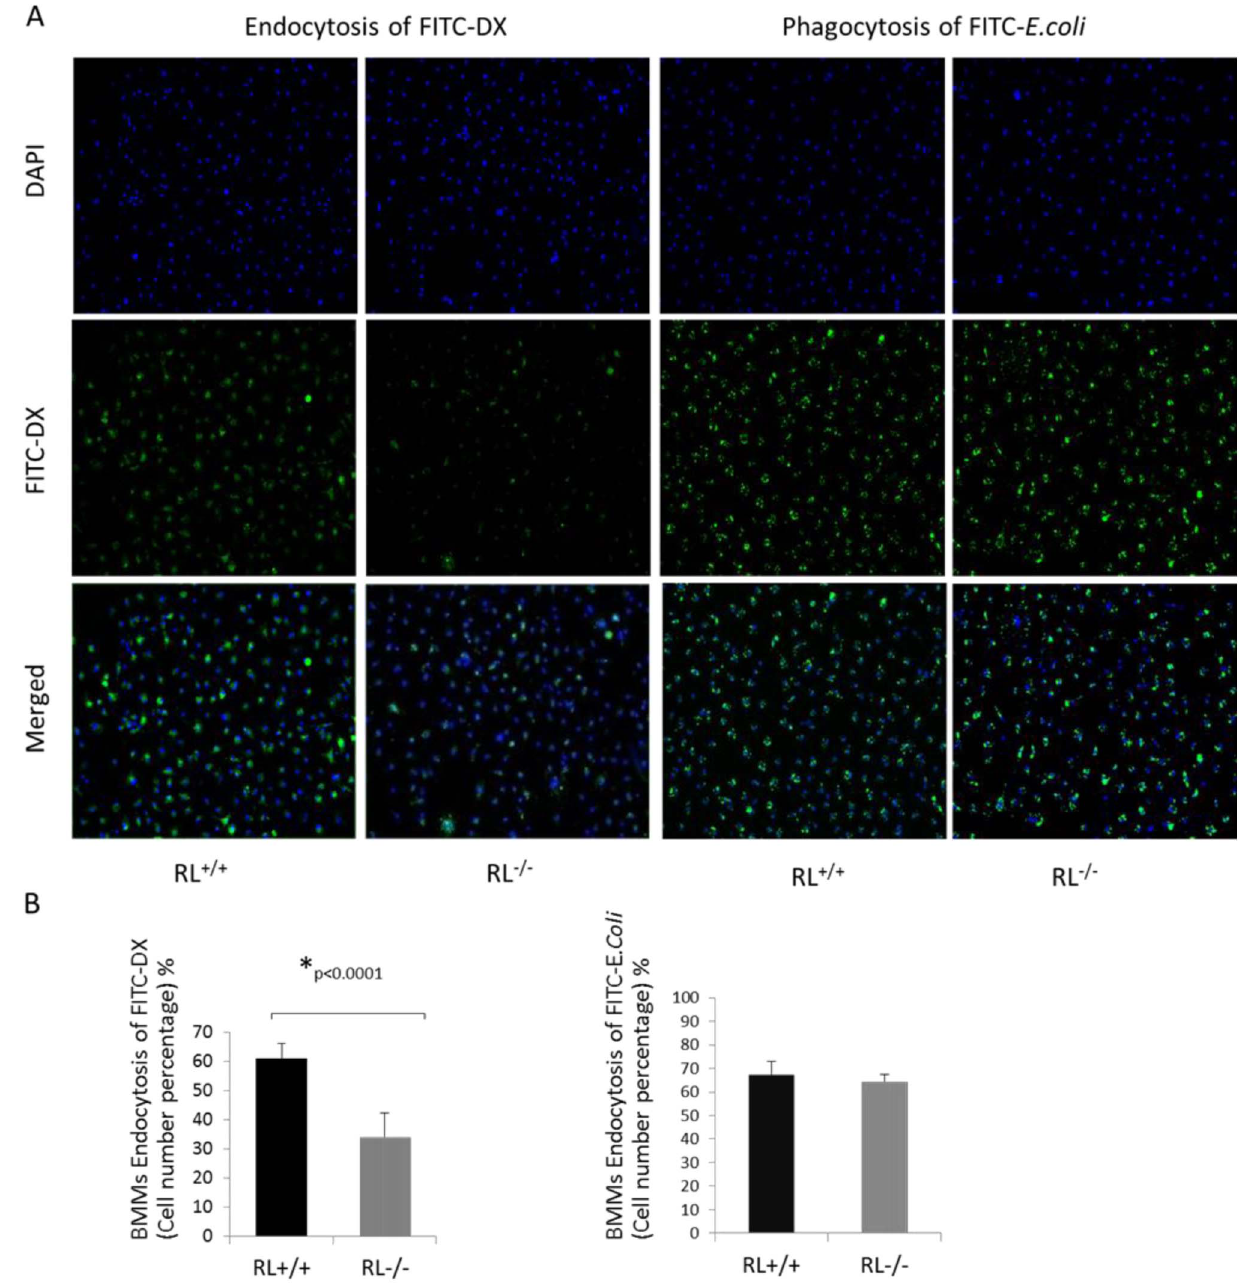
Figure 2. Role of RNase L in macrophage endocytosis and phagocytosis. (A) RNase L deficient and wild type BMMs were activated with LPS (0.5 m g/ml) for 48 hours, followed by incubating with FITC-Dextran 40,000 (1 m g/ml) or FITC- E . coli (bacterial to macrophage ratio=50:1) at 37 u C for 1 h. After incubation, the cells were fixed with 4% paraformalhyde for 10 min and washed thoroughly with ice cold phosphate-buffered saline (PBS). Extracellular fluorescence was quenched by trypan blue. The cells with fluorescence were photographed under a fluorescent microscope. The photos are shown from one of five experiments. (B) The fluorescent cell numbers were averaged from eight fields per well and present as Mean 6 SD, *p , 0.0001.